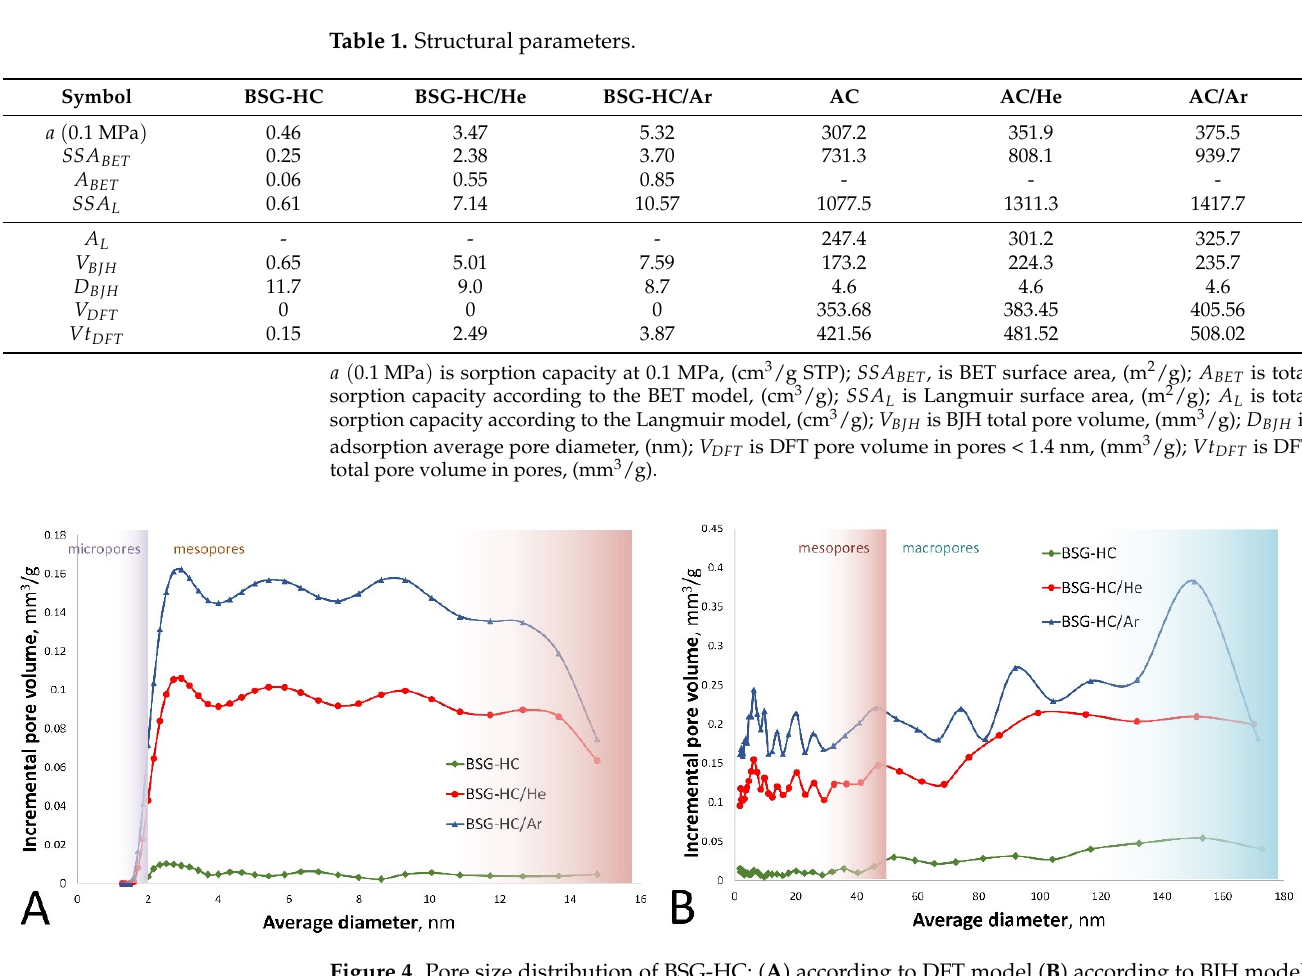
Figure 4. Pore size distribution of BSG-HC: ( A ) according to DFT model ( B ) according to BJH model.